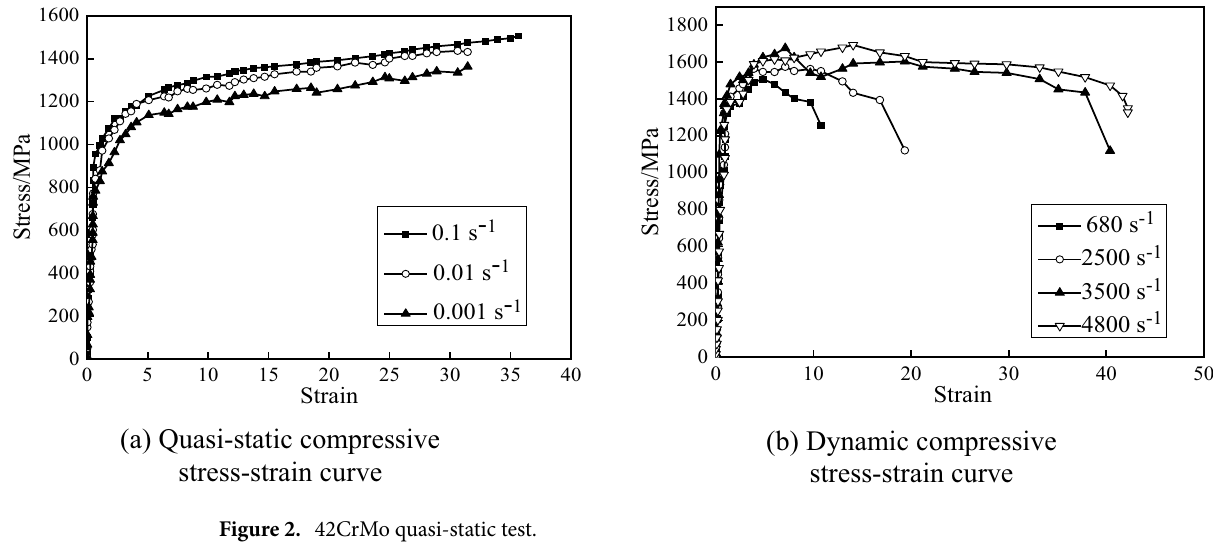
Figure 2. 42CrMo quasi-static